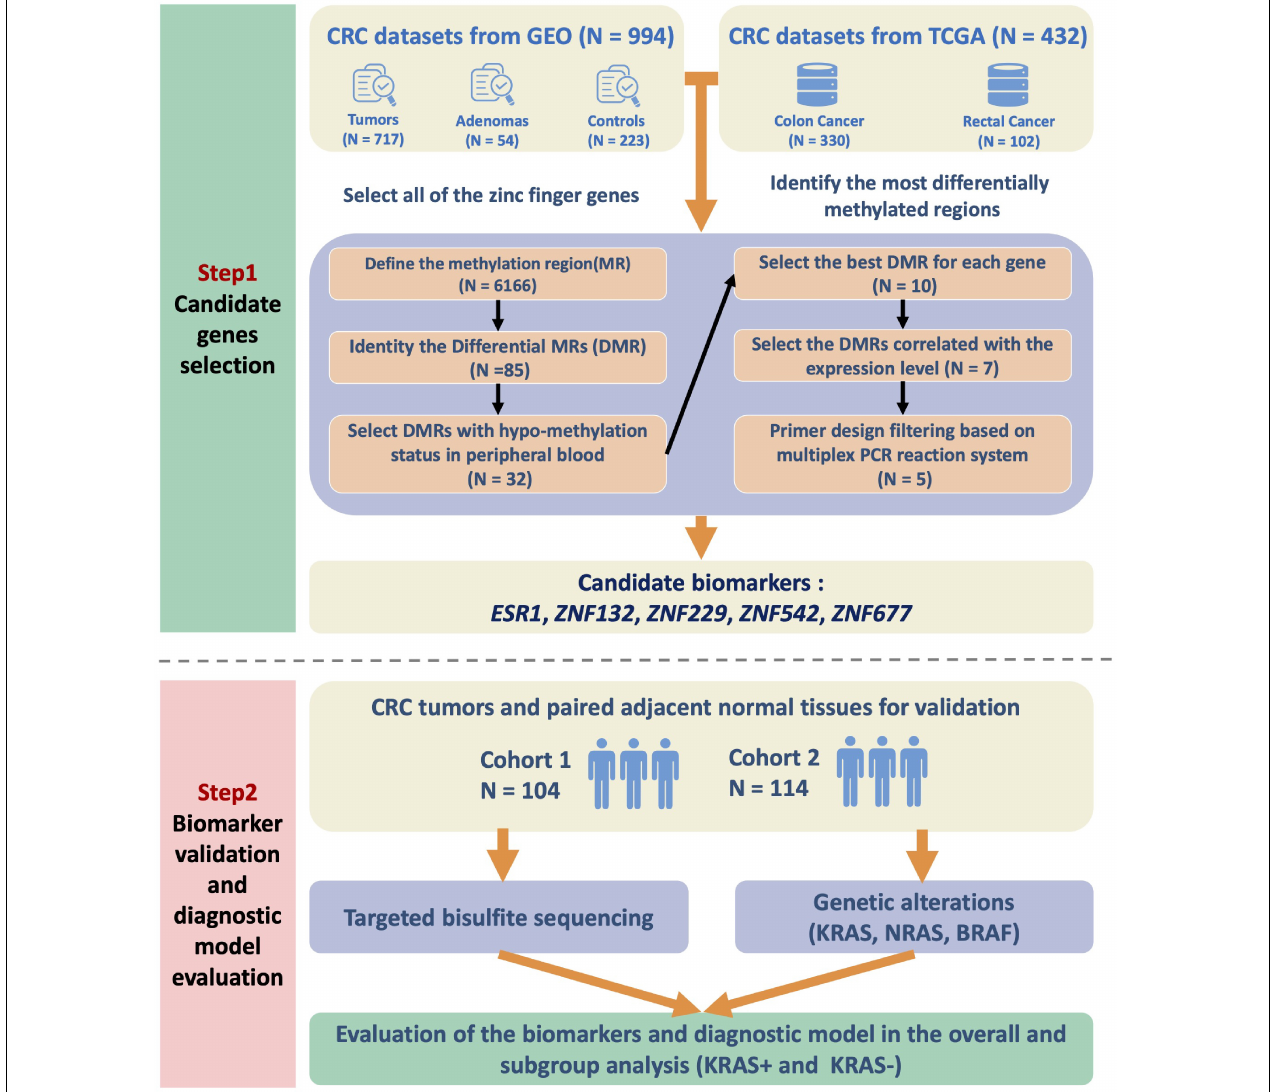
FIGURE 1 | Flow chart of the study design. We first integrated the high-throughput DNA methylation microarray datasets from GEO and TCGA databases and examined the methylation profiles of all the zinc finger genes. To identify the most significantly differentially methylated genes in CRC, we first defined the methylation region and selected the differentially methylated regions (DMRs). The methylation status of the candidate DMRs in the whole blood, peripheral blood mononuclear cells and peripheral blood leukocytes were also utilized for biomarker filtering. The correlations between the methylation and expression level of the candidates were also calculated for further filtering. Finally, the candidate zinc finger genes-based biomarkers were validated in two independent CRC cohorts of the Han Chinese population. In addition, the KRAS mutation status of the patients was also detected and assessed for subgroup analysis.